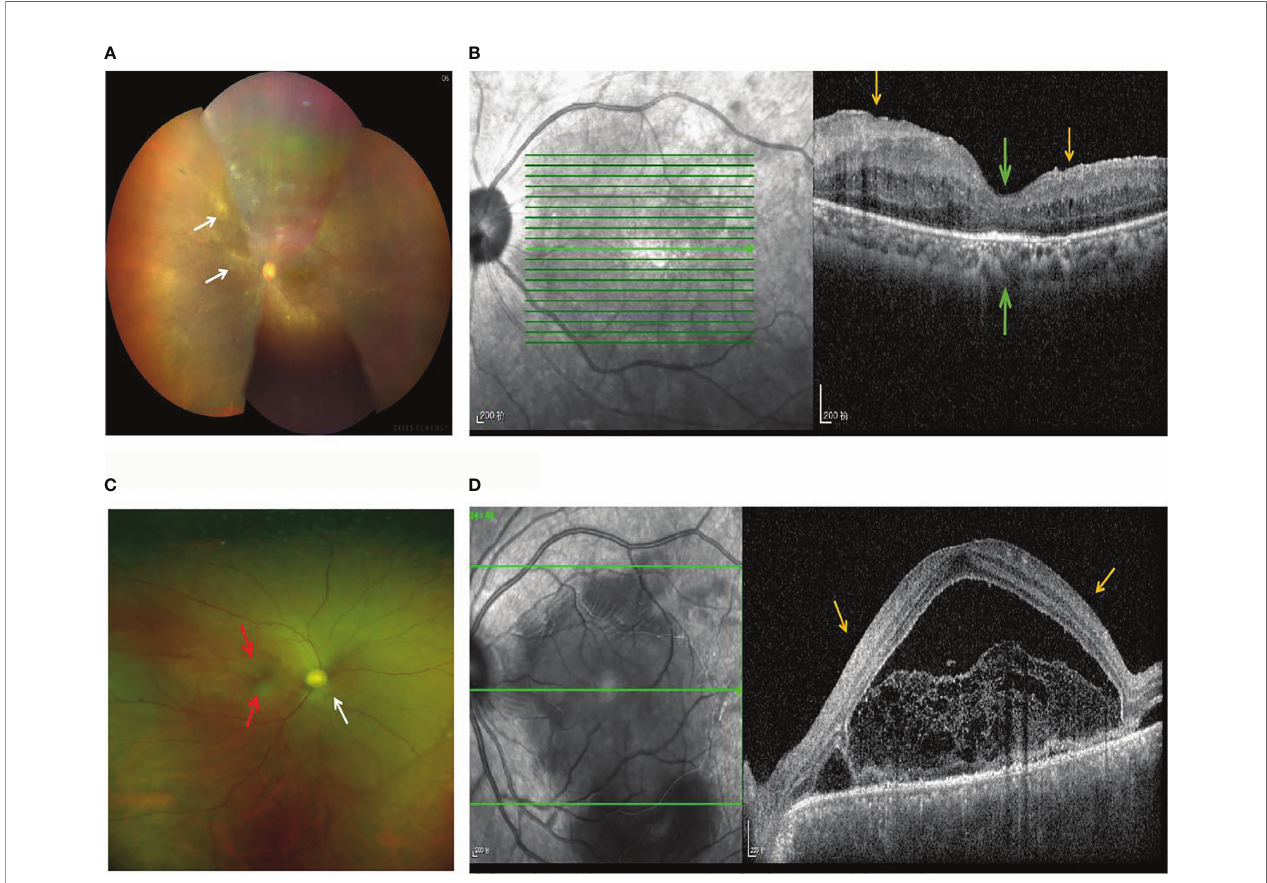
FIGURE 1 | Fundus imaging and OCTA in patients with BD and VKH. (A) The color fundus photograph of a patient with BD shows perivenous white sheathing (white arrows). (B) OCTA of a patient with BD shows a wedge-shaped localized retinal nerve fi ber layer micro-thinning (yellow arrows) in the superior macula and the papillomacular bundle, and the central foveal thinning (green arrows). (C) The fundus photograph of a patient with VKH syndrome shows swollen optic disks (white arrows), serous in fl ammatory in fi ltration and exudation (red arrows), and an unclear optic disk boundary. (D) OCTA of a patient with VKH syndrome shows the presence of subretinal fl uid, with multifocal SRDs (yellow